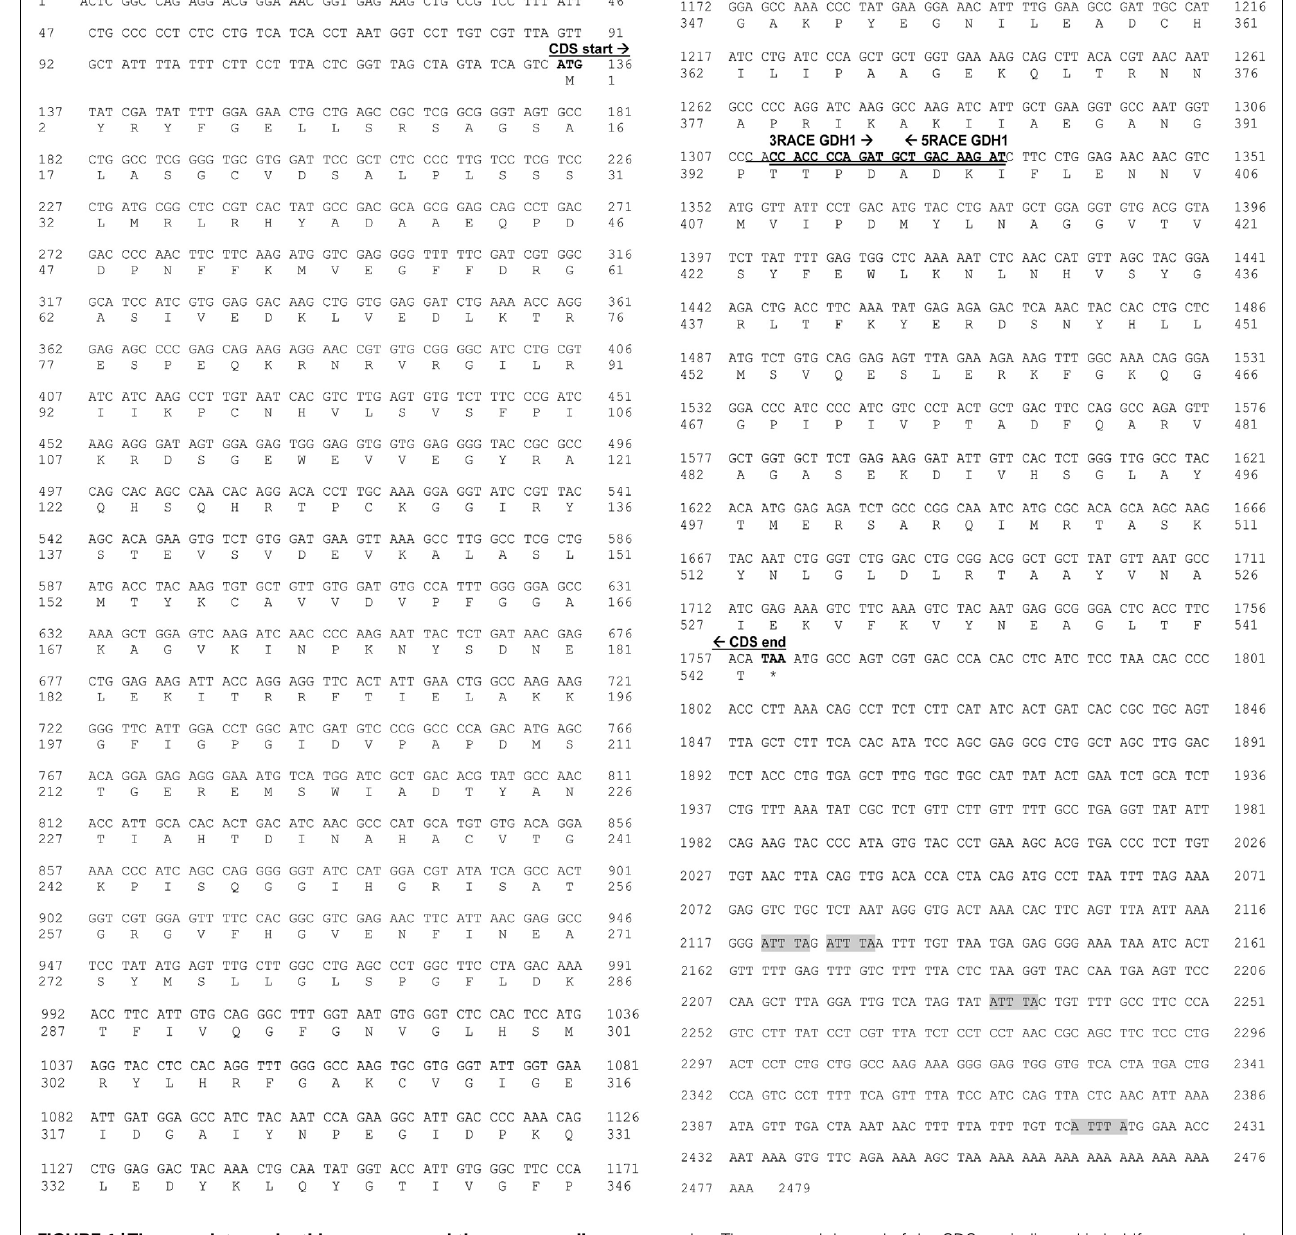
codon.The start and the end of the CDS are indicated in boldface type, and the priming positions of the RACE primers used are underlined and indicated in boldface type. Pentameric motifs corresponding to AU-rich elements (AREs) are highlighted in